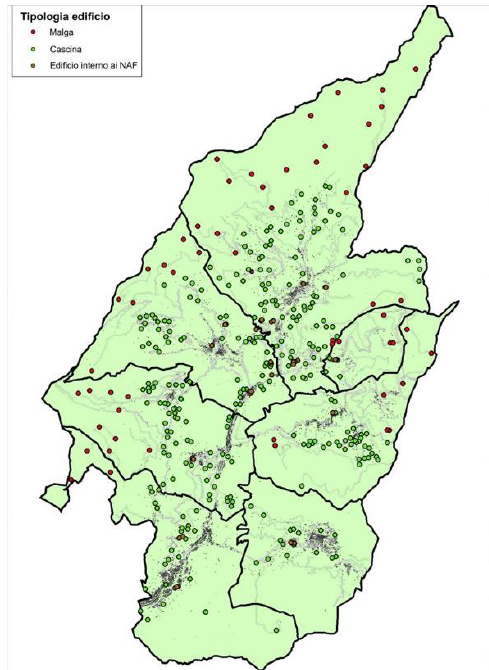
Figure 6. Map of rural buildings in the Trompia Valley divided by category.